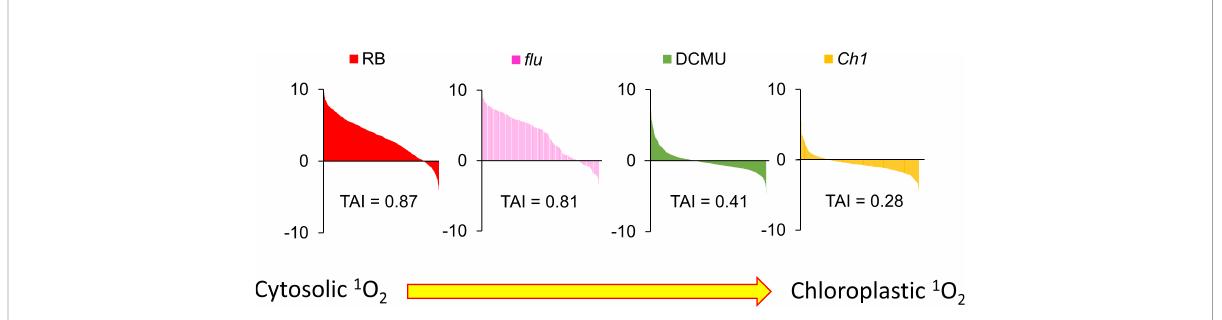
FIGURE 8 Cytosolic but not chloroplastic 1 O 2 production are correlated with CHX-induced transcriptomic responses. Translational Attenuation Index analysis of RB, fl u , DCMU and Ch1 transcripts. Genes were obtained from various transcriptomic experiments in the literature for the speci fi c treatments and subjected to a 2-fold expression threshold and p<0.05 signi fi cance cutoff. Each list of >100 genes were then screened against a dataset of cycloheximide treatment and their expression values under cycloheximide treatment are displayed accordingly. The data here were obtained from public databases (CHX – GSE111284; RB -GSE111285; fl u - GSE10509; DCMU - GSE111287; Ch1 -